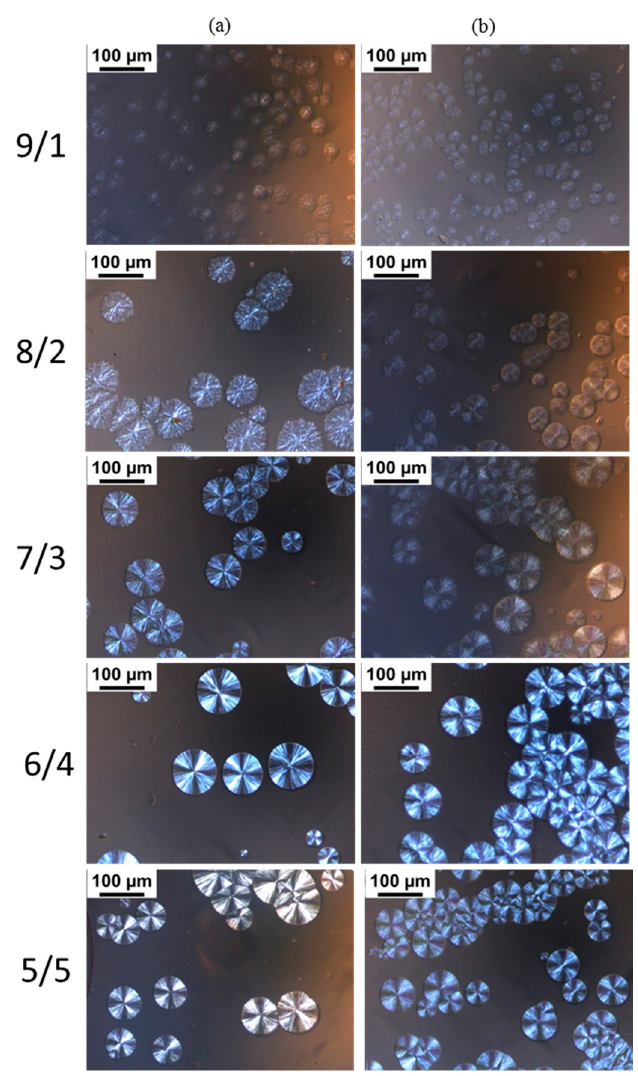
Figure 4. Polarizing optical microscopy (POM) images of the blends with different L/D ratios isothermally crystallized at 160 °C: ( a ) PLLA/PDLA-PEG 1k -PDLA100; ( b ) PLLA/PDLA-PEG 4k